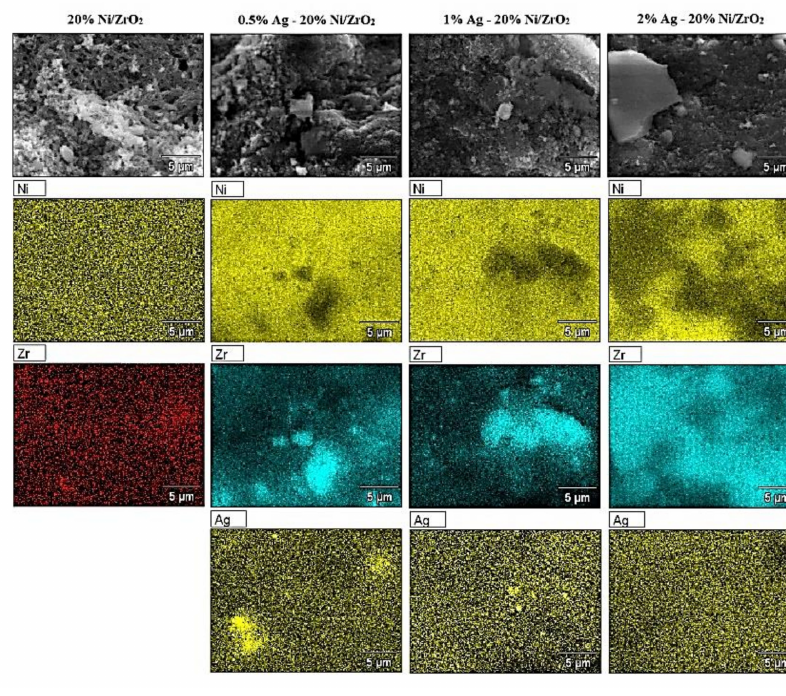
Figure 11. SEM images of mono- and bimetallic nickel catalysts.